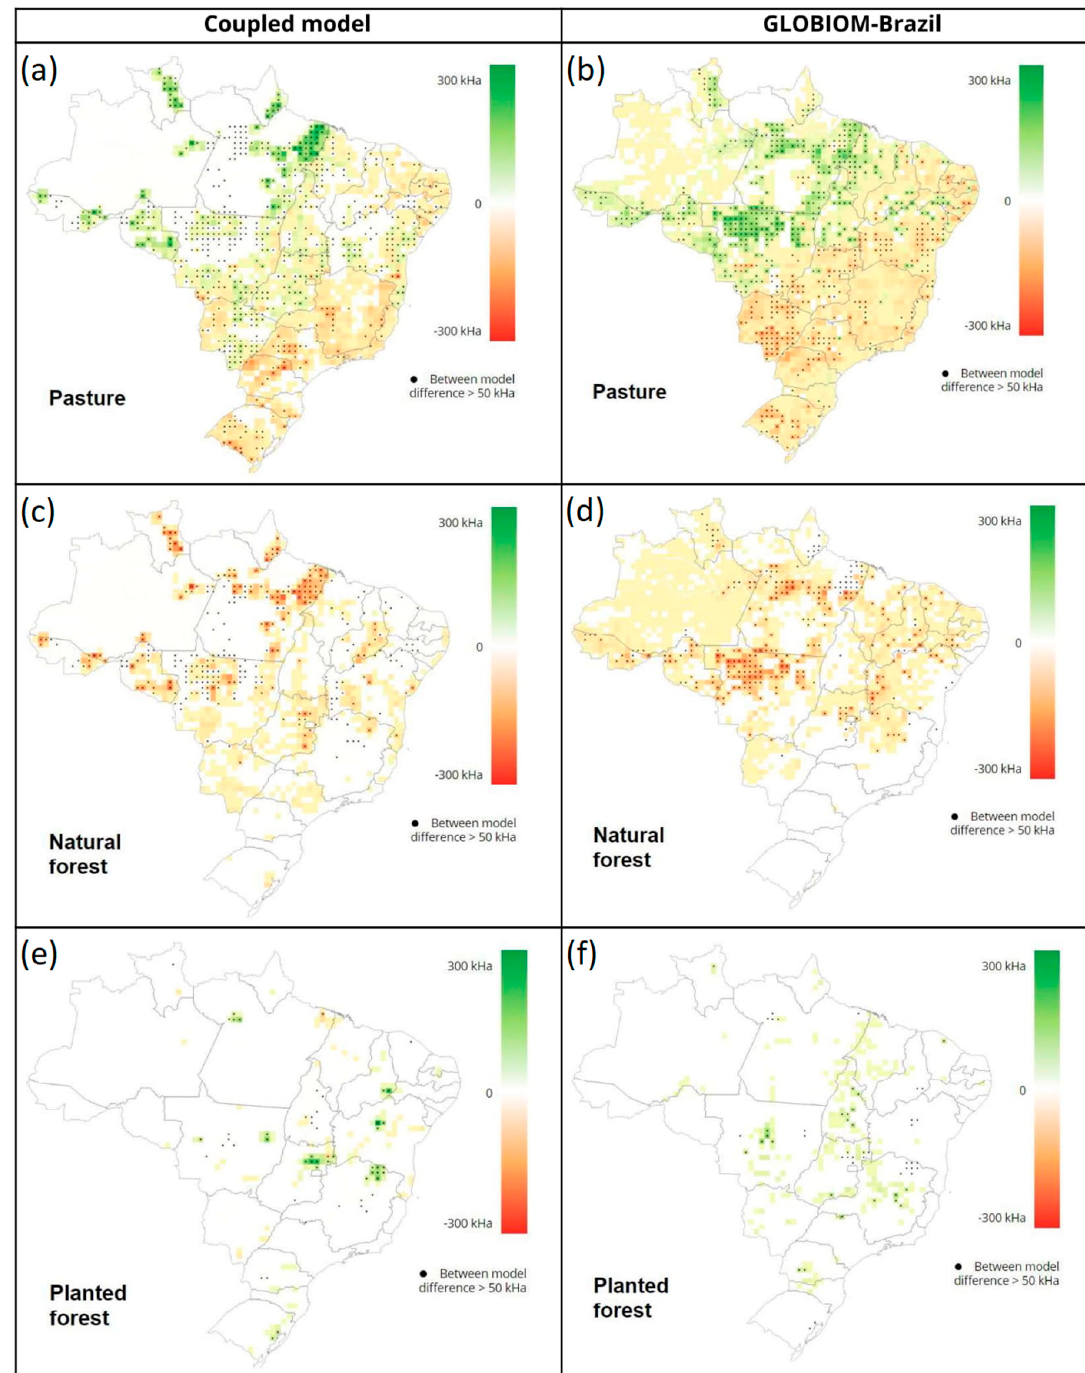
Figure 7. Projected land ‐ use changes for the period 2010 to 2030 by the coupled model (left) and GLOBIOM ‐ Brazil (right). Projections are compared per land ‐ use class: pasture (a,b), natural forest (c,d), planted forest (e,f), cropland (g,h), sugarcane (i,j), and natural non ‐ forest land (k,l). Colors indicate the amount of increase (green) or decrease (red) per grid cell over the time periods. The black dots indicate grid cells with large (> 50 kHa) differences in projected changes between the two models. The threshold of 50 kHa was based on the frequency distribution of the